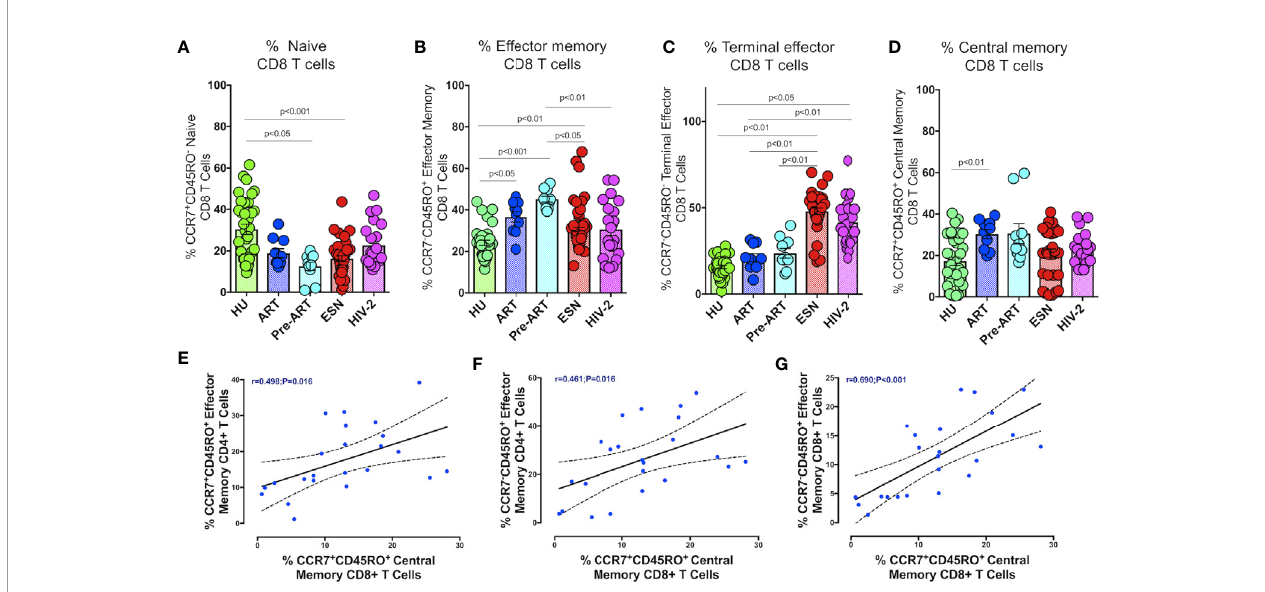
FIGURE 4 | Distribution of CD8 + memory T cells responses in the study groups. Graphical representation of the enumeration of CD8 + memory T cells subsets de fi ned using CCR7 and CD45RO expression. (A) Frequency of CCR7+CD45RO- naïve CD8 + T cells in the HU, HIV-1+ART+, HIV-1+ART-, HIV-2 and HESN groups. (B) Frequency of CCR7-CD45RO+ Effector Memory CD8 + T cells in the HU, HIV-1+ART+, HIV-1+ART-, HIV-2 and HESN groups. (C) Frequency of CCR7- CD45RO- Terminal Effector Memory CD8 + T cells HU, HIV-1+ART+, HIV-1+ART-, HIV-2 and HESN groups. (D) Frequency of CCR7+CD45RO+ Central Memory CD8 + T cells in the HU, HIV-1+ART+, HIV-1+ART-, HIV-2 and HESN groups. The scatter dot plots summarize the % frequency of total memory T cells (median, 1st, and 3rd quartiles). P values were calculated using the K-Wallis test. Sub-group analysis was performed using Dunn ’ s test. (E) Correlation between frequency of CCR7-CD45RO+ Effector Memory CD4 + T cells and frequency of CCR7+CD45RO+ Central Memory CD8 + T cells in HIV-2 infected individuals. (F) Correlation between frequency of CCR7-CD45RO+ Effector Memory CD4 + T cells and frequency of CCR7-CD45RO+ Effector Memory CD8 + T cells in HIV-2 infected individuals. (G) Correlation between frequency of CCR7-CD45RO+ Effector Memory CD4 + T cells and frequency of CCR7+CD45RO+ Central Memory CD8 + T cells in HIV-2 infected individuals. (Note: HU: HIV unexposed seronegative controls, HIV-1+ART+: HIV-1-infected women on ART; HIV-1+ART-: HIV-1-infected women naïve to ART; HESN: HIV exposed seronegative individuals; HIV-2: HIV-2 infected